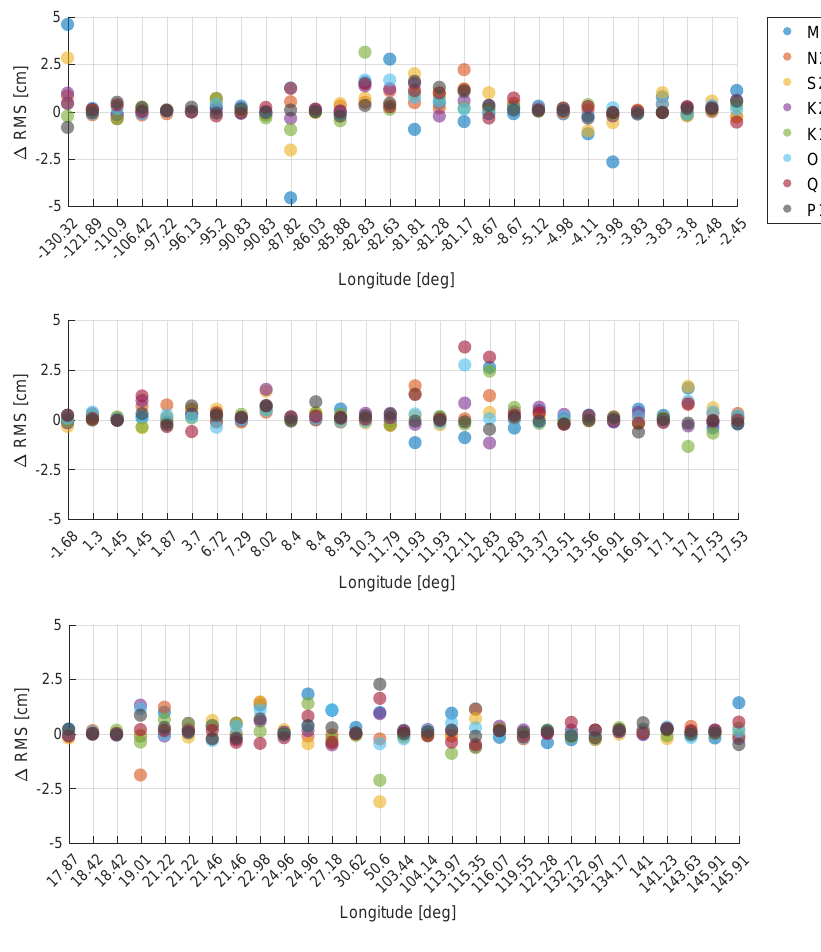
Figure 6. Difference of RMS for major constituents at the CNTG. The values are plotted against the longitude of their location.